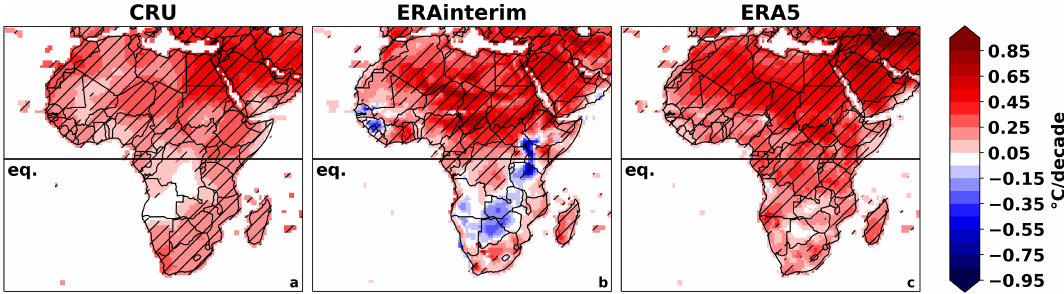
Figure 7. Trend of annual mean near-surface temperature in observations (CRU, ( a )), ERA-interim ( b ) and ERA5 ( c ) from 1981 to 2017. Hatching represents regions where trends are significant at the 1%